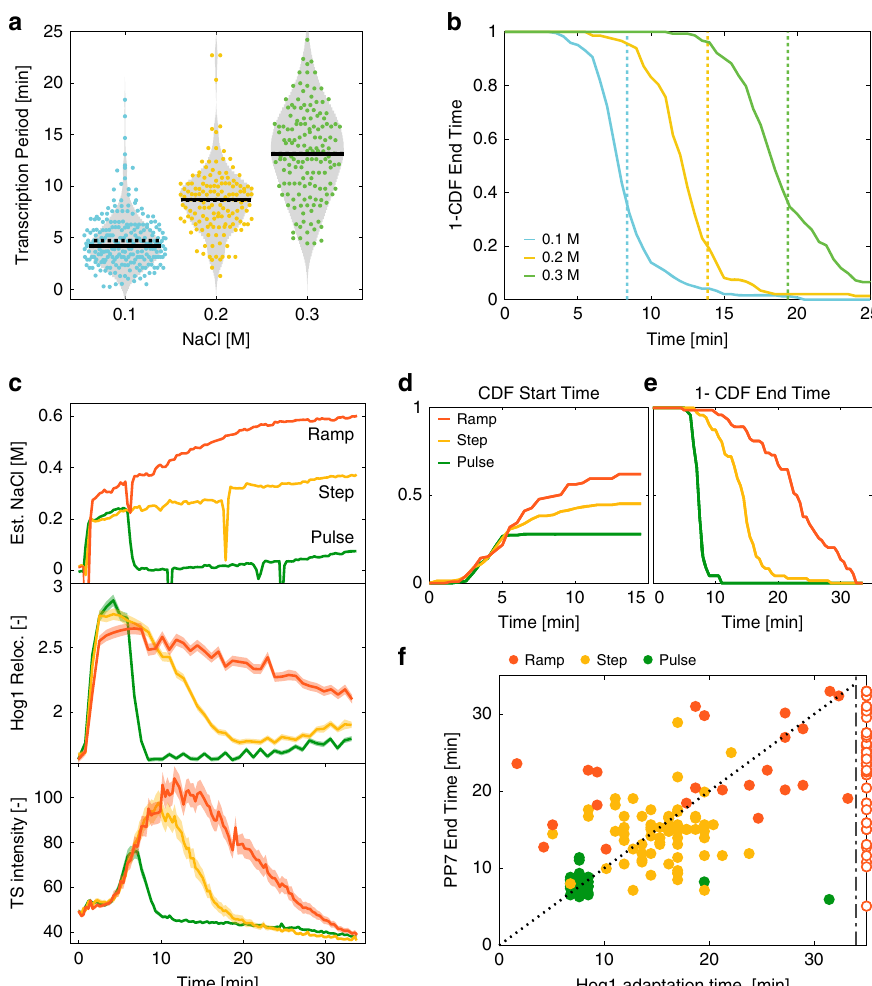
Fig. 6 Hog1 activity and promoter identity control the shutoff of transcription. a Violin plots representing the Transcription Period (time difference between End Time and Start Time) measured for the p STL1 -PP7sl reporter following 0.1, 0.2, and 0.3 M NaCl stresses. Each dot represents the value calculated from a single cell. The solid line is the median and the dashed line the mean of the population. b One minus the cumulative distribution function of End Times for the p STL1 -PP7sl reporter. The vertical dashed lines represent the median adaptation time of Hog1 for the three different stress levels. c Dynamics of the estimated NaCl concentrations in the medium for the pulse, step, and ramp experiment protocols (upper panel, Methods). Corresponding Hog1 relocation dynamics (middle panel) and p STL1 -PP7sl transcription site intensity (lower panel). The mean of at least 180 cells is represented by the solid line. The shaded areas represent the s.e.m. d Cumulative distribution function (CDF) of the Start Time for all cells in the pulse, step, and ramp experiments. The CDF at 15 min represents the fraction of responding cells for each condition. e One minus the cumulative distribution function of End Times only for the responding cells in the pulse, step, and ramp experiments. f Correlation between the Hog1 adaptation time and the PP7 End Time measured in the same cells in the pulse, step, and ramp experiments. The open markers indicate cells where Hog1 has not adapted at the end of the time lapse. Adaptation time is arbitrarily set to 35 min for this sub-population. Source data are provided for c